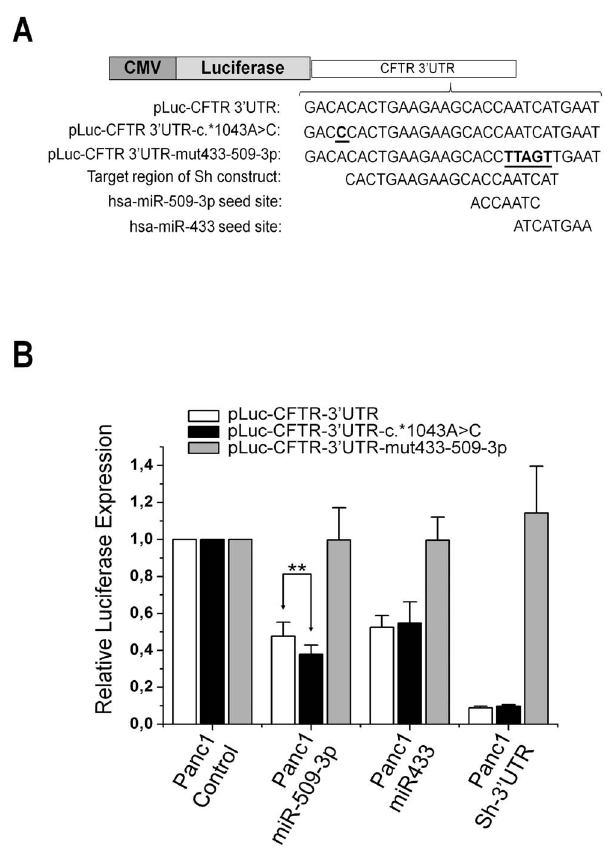
Figure 4. Experimental evaluation of c*1043A . C mutation effect on miRNAs affinity.A : luciferase reporter constructs derived from pGL3-Control vector. Underlined and in bold is shown the location of the variant c.*1043A . C or altered nucleotide bases to destroy the seed overlapping region of miR-433 and miR-509-3p in the CFTR 3 9 UTR. B : luciferase expression from pLuc-CFTR-3 9 UTR or mutated form constructs transient transfected in different Panc-1 cells stably espressing the miR-433, miR-509-3p or the sh-3 9 UTR. Data reported here are the means 6 St.Dev., **P , 0.01